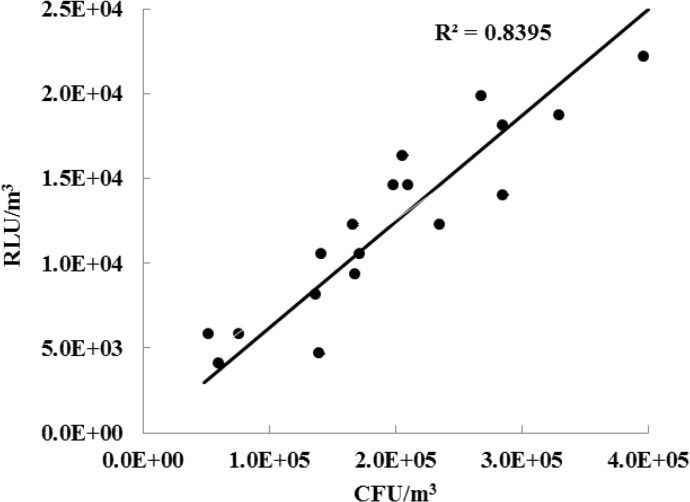
Correlation between RLU/m3 and CFU/m3 of S. epidermidis.